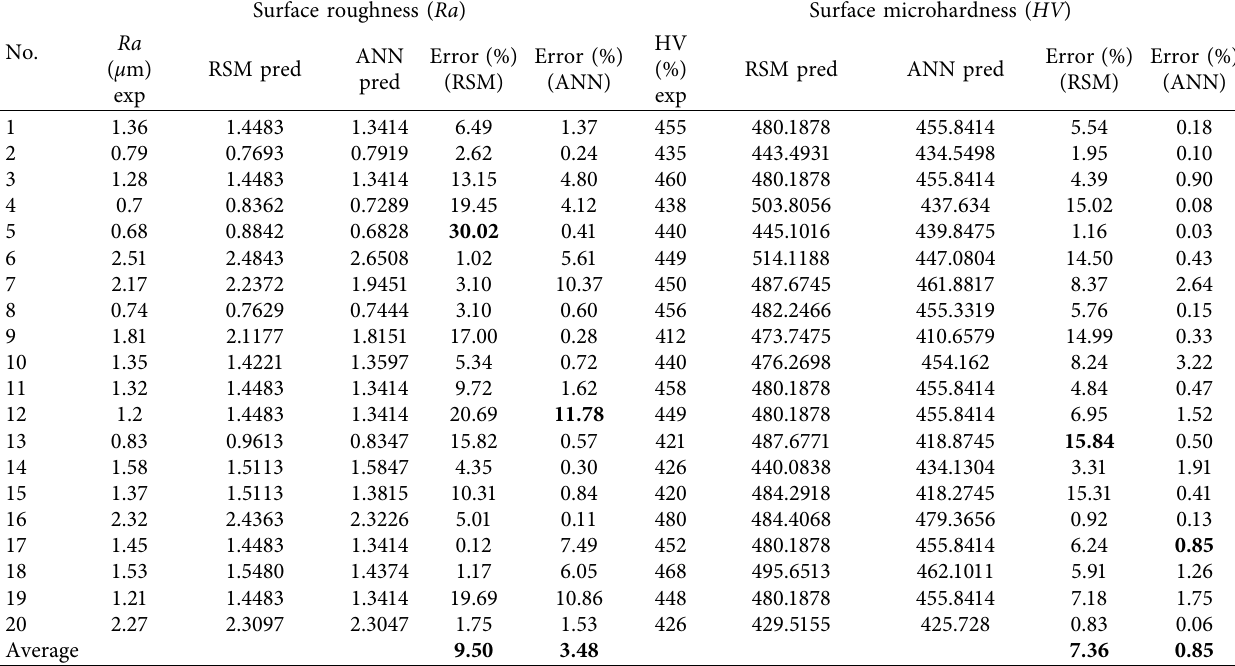
Table 9: Comparison of the measured and predicted value.